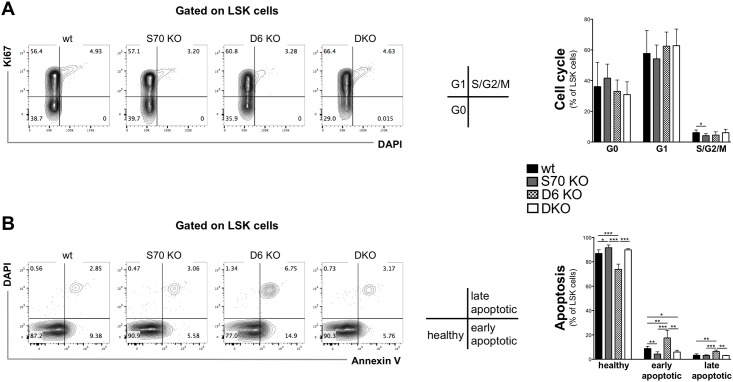
Effects of SWAP-70- and DEF-6-deletion on cycling and apoptosis of LSK cells.(A) Representative flow cytometric analysis of DNA content (DAPI) and intracellular Ki-67 expression on gated Lin-kit+Sca+ LSK cells derived from 12-week-old wt, Swap-70-/- (S70 KO), Def6-/- (D6 KO) and Swap-70-/-Def6-/- (DKO) mice. The percentage of cells in the respective cell cycle stage is indicated next to the corresponding gate. Graph depicts mean percentage of LSK cells that are in G0, G1 or S/G2/M phase of the cell cycle. (B) Representative flow cytometric analysis of apoptosis in LSK cells detected with Annexin V and DAPI. Graph displays mean percentage of Annexin V+ DAPI- early apoptotic and Annexin V+ DAPI+ late apoptotic LSK cells (n = 4–6 mice per genotype).